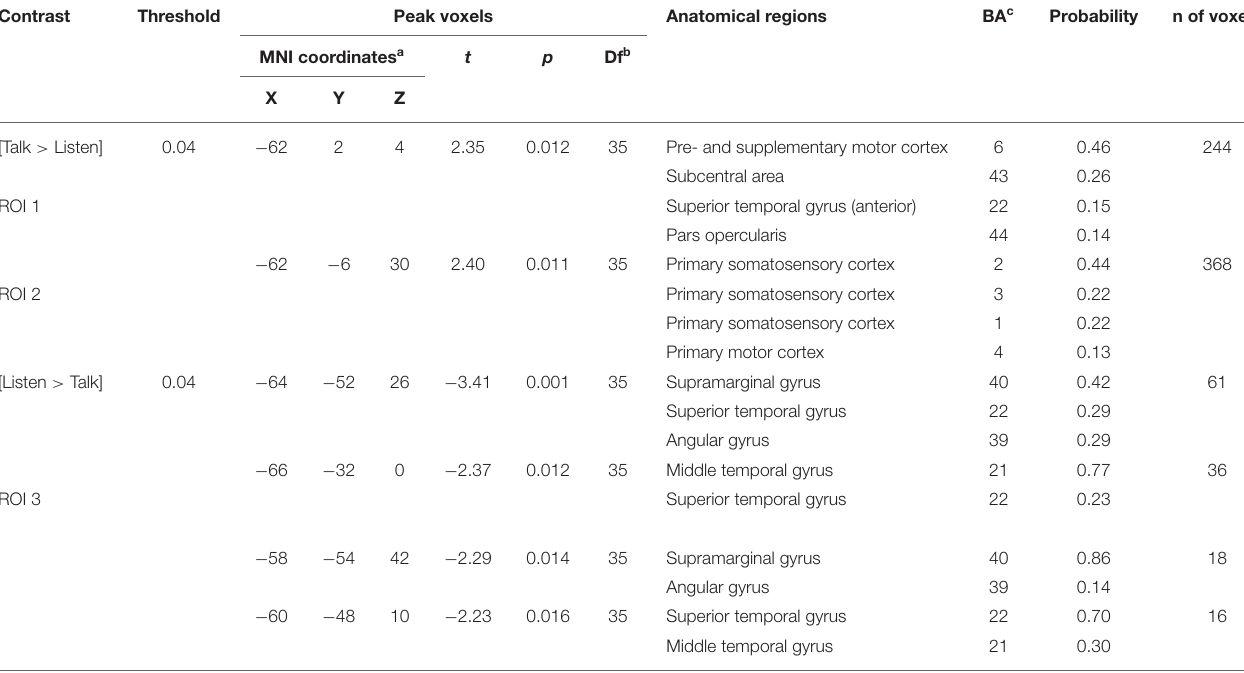
TABLE 1 | GLM analysis: group median coordinates, anatomical regions, and atlas-based probabilities [Talking > Listening].